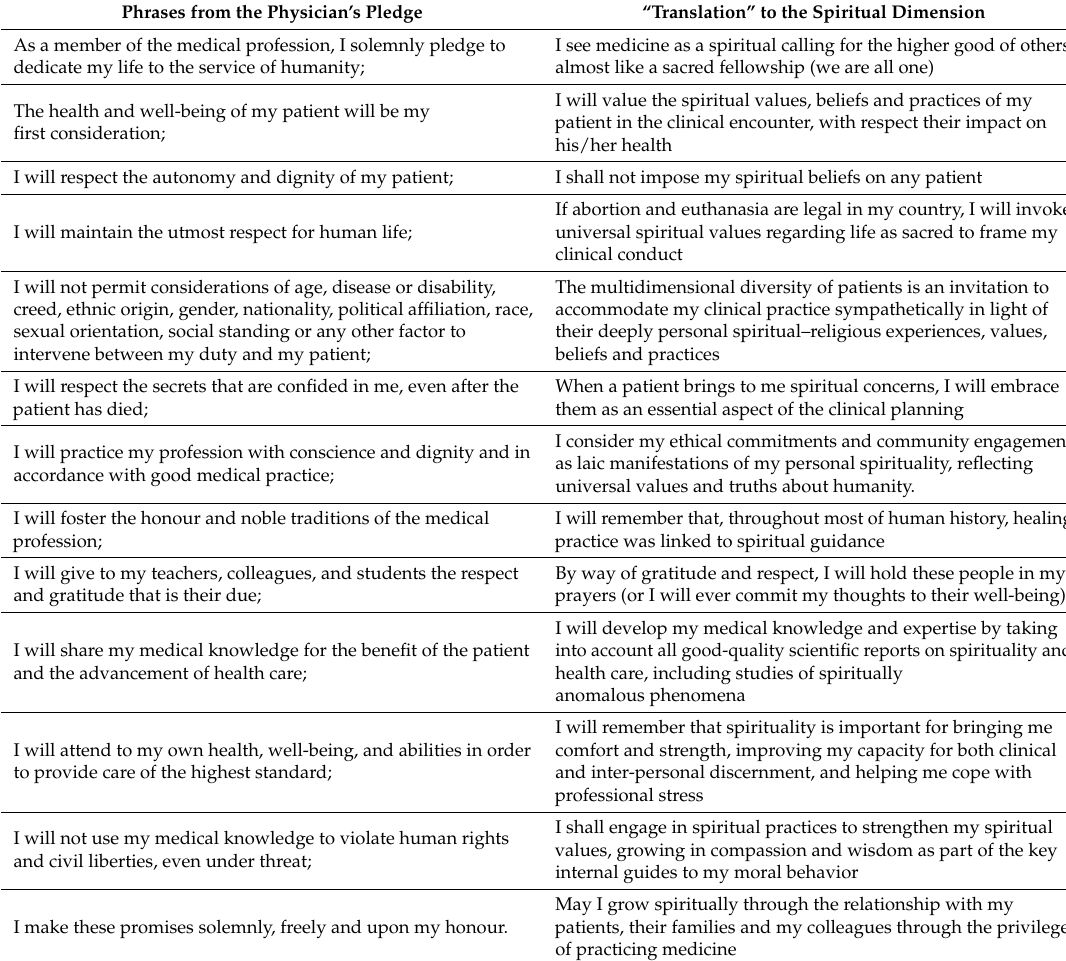
Table 1. Phrases from Physician’s Pledge on the Declaration of Geneva, each one confronted with its “translation” to the spiritual